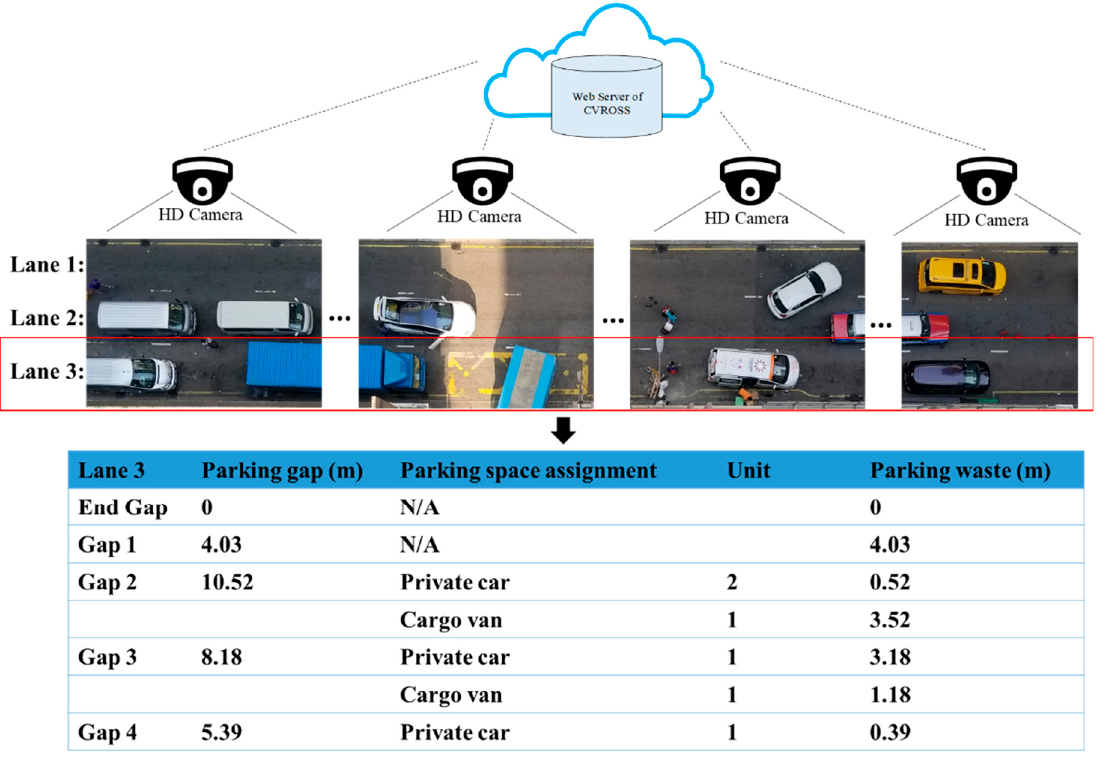
Figure 16. Calculation of available parking spaces in the case of occupation by an object.